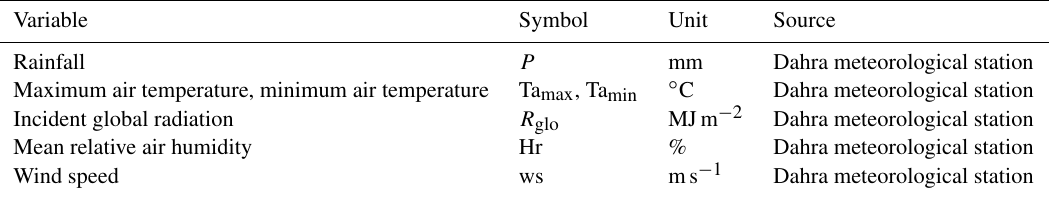
Table A1. Daily climatic data of the Dahra station used for the forc- ing of the STEP–GENDEC–NOFlux model.